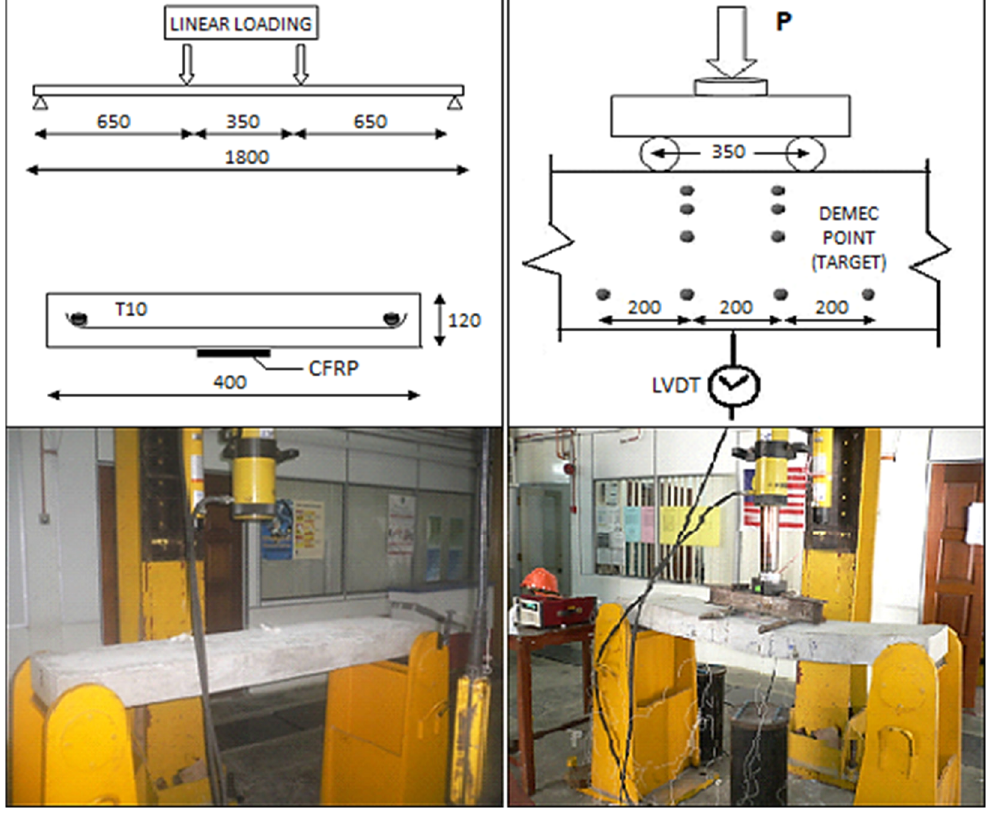
Figure 6. Instrument configuration for testing RC slabs strengthened with CFRP under linear load.